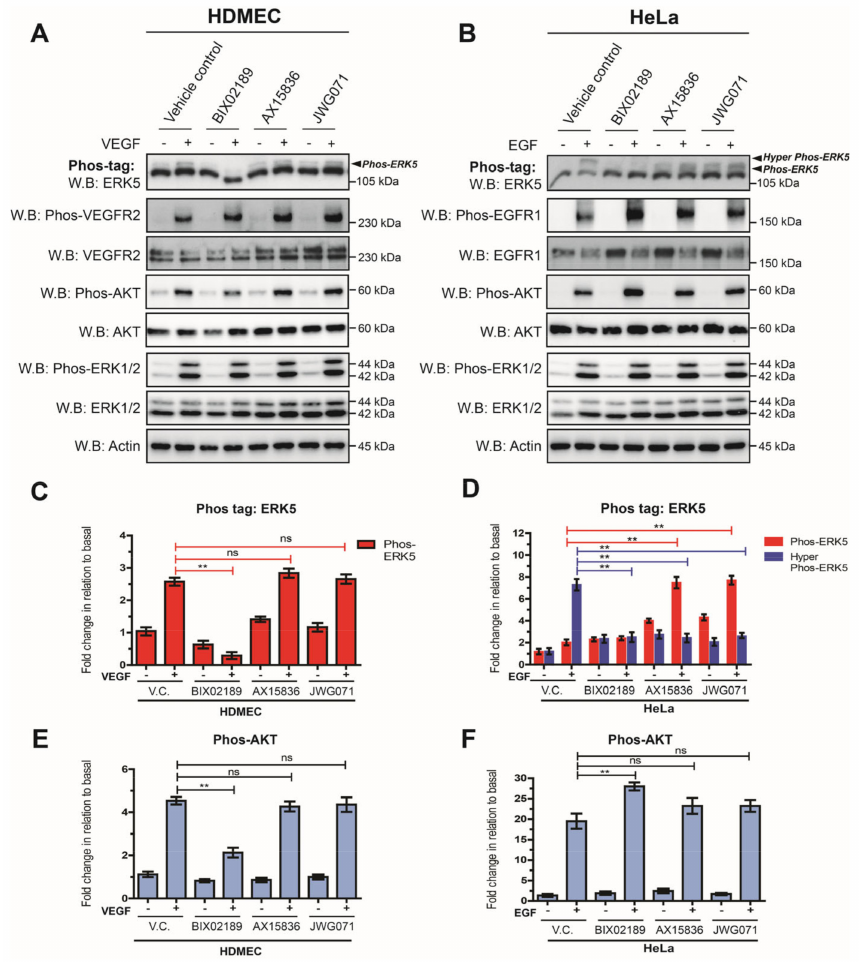
Figure 5. VEGF-mediated ERK5 activation regulates AKT phosphorylation in endothelial cells. ( A ) HDMECs or ( B ) HeLa cells were serum-starved overnight and then treated with either vehicle control (V.C.; 0.1% DMSO), or the MEK5 inhibitor BIX02189 (1 µ M), or the ERK5 inhibitors AX15836 (1 µ M) or JWG071 (1 µ M) for 1 h prior to stimulation with either VEGF (50 ng/mL) or EGF (50 ng/mL) for 10 min. Cells were lysed in RIPA buffer and lysates were resolved by 10% SDS-PAGE or Phos- tag SDS-PAGE and analysed by Western blotting. ( C ) Quantification of HDMECs Phos-tag ERK5 level by densitometric analysis. Data are shown as mean fold change relative to basal (vehicle control) normalised to Actin level ± SEM ( n = 3). ( D ) Quantification of HeLa Phos-tag ERK5 level by densitometric analysis. Data are shown as mean fold change relative to basal (vehicle control) normalised to Actin level ± SEM ( n = 3). ( E ) Quantification of HDMECs Phos-AKT level by densitometric analysis. Data are shown as mean fold change relative to basal (vehicle control) normalised to Actin level ± SEM ( n = 3). ( F ) Quantification of HeLa Phos-AKT level by densitometric analysis. Data are shown as mean fold change relative to basal (vehicle control) normalised to Actin level ± SEM ( n = 3). Statistical analysis: one-way ANOVA followed by Tukey’s post hoc test, where ** p < 0.01, ns = not